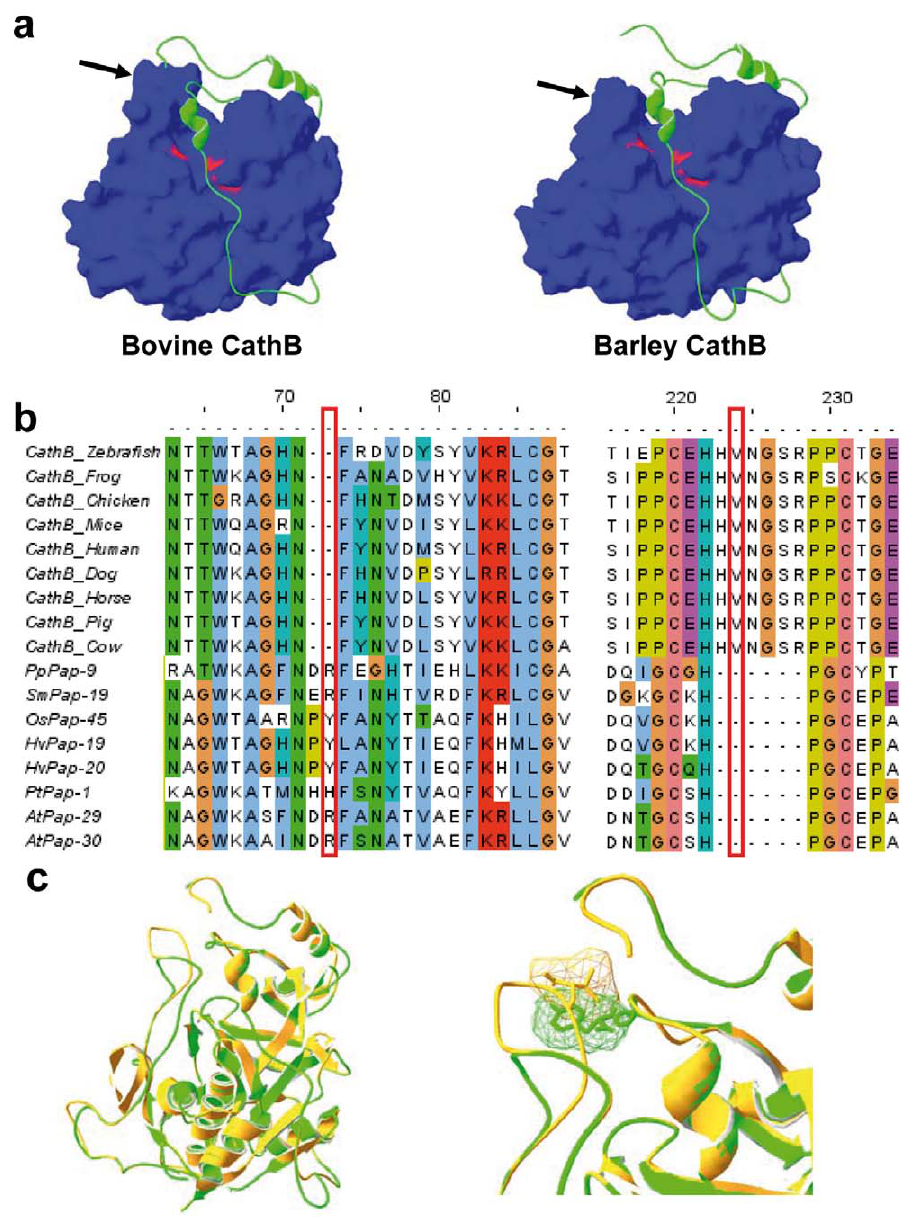
Figure 2. Structure-sequence analysis of animal and plant B cathepsins. (a) Homology models of bovine and barley HvPap-19 cathepsin B peptidases created using SWISS-MODEL. The propeptides (green) and the mature enzymes (blue; catalytic triad residues in red) are shown. Arrows mark the occluding loop domains. (b) Alignment of the amino acid regions involved in the interaction between the occluding loop and the propeptide in different animal and plant species. Alignment was generated using the MUSCLE program. The locations of residues potentially involved in steric clashes (red boxes) are indicated. Pp, Physcomitrella patens ; Sm, Selaginella moellendorffii ; Os, Oryza sativa ; Hv, Hordeum vulgare ; Pt, Populus trichocarpa ; At, Arabidopsis thaliana . (c) Ribbon plots showing the structural overlay of three-dimensional models for bovine cathepsin B (orange) and HvPap-19 (green). Close-up image shows the molecular surface of V174 located in the occluding loop of bovine cathepsin B and Y59 in the propeptide of HvPap-19, which are potentially involved in a steric clash. doi:10.1371/journal.pone.0037234.g002 acid residues of the propeptide and the short occluding loop. However, a steric clash would occur between the amino acid residues Y59 of the HvPap-19 propeptide and V174 located at the occluding loop of the bovine cathepsin B (Fig. 2c).